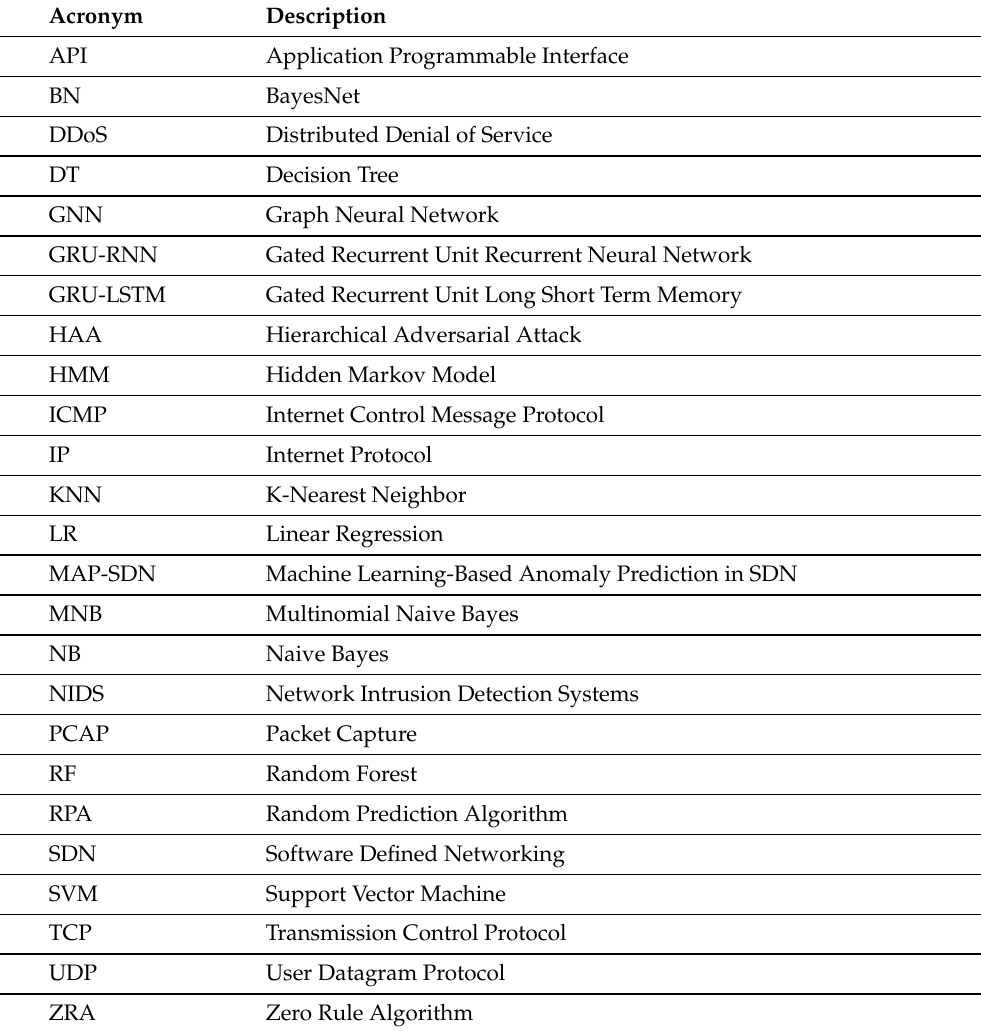
Table 1. Major acronyms used in the